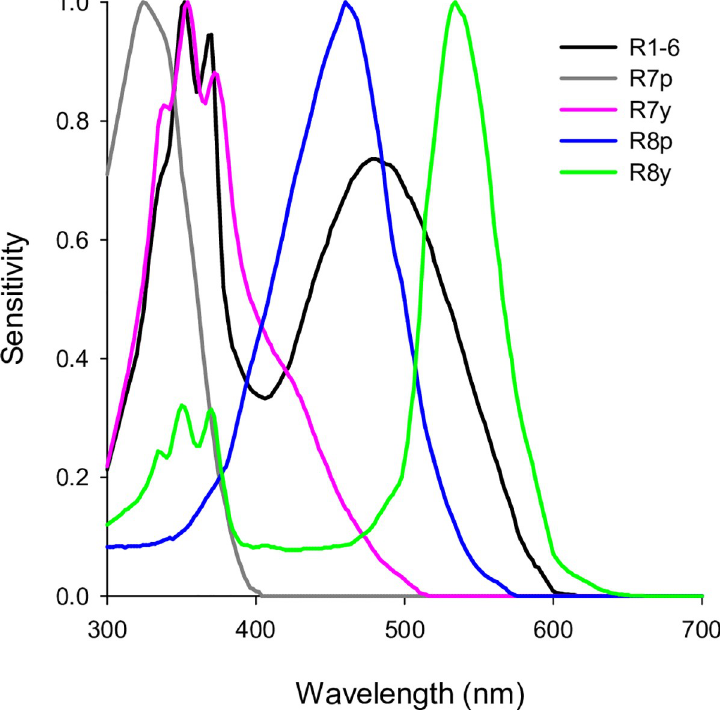
Fig 1. The spectral sensitivities of photoreceptors in higher flies. Flies possess five spectral types of photoreceptor across the majority of their compound eyes. The responses of these photoreceptors to light reflected from target surfaces provide the input to the visually guided behaviour of tsetse, and thus provide fly-relevant metrics of target appearance. Photoreceptor-based models statistically relate fly photoreceptor responses calculated from the reflectance spectra of coloured fabrics to the numbers of tsetse caught at traps and targets constructed from those fabrics. These models suggest that photoreceptor R7y contributes positively to tsetse attraction, while photoreceptors R7p and R8y contribute negatively [7, 8]. Such models provide a means to evaluate and refine the fly-relevant colour properties of fabrics for tsetse targets. Data are as presented in [8], based upon